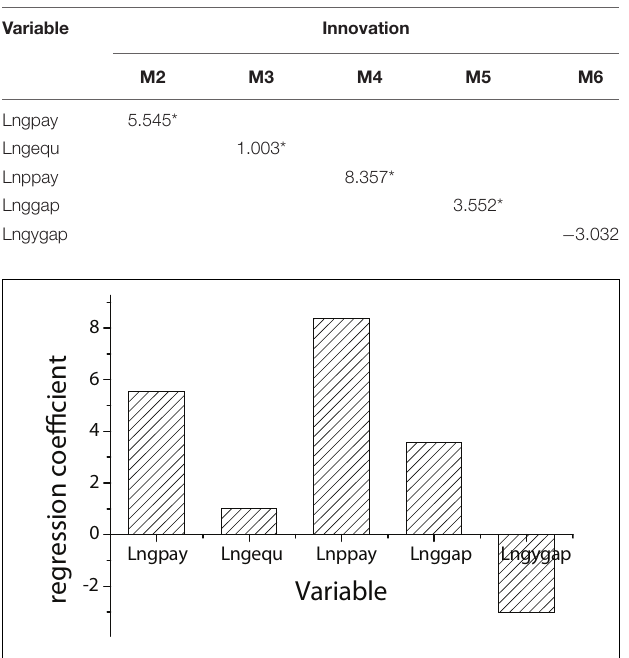
FIGURE 3 | Multiple regression coefficient statistics of salary, salary gap and enterprise innovation efficiency.